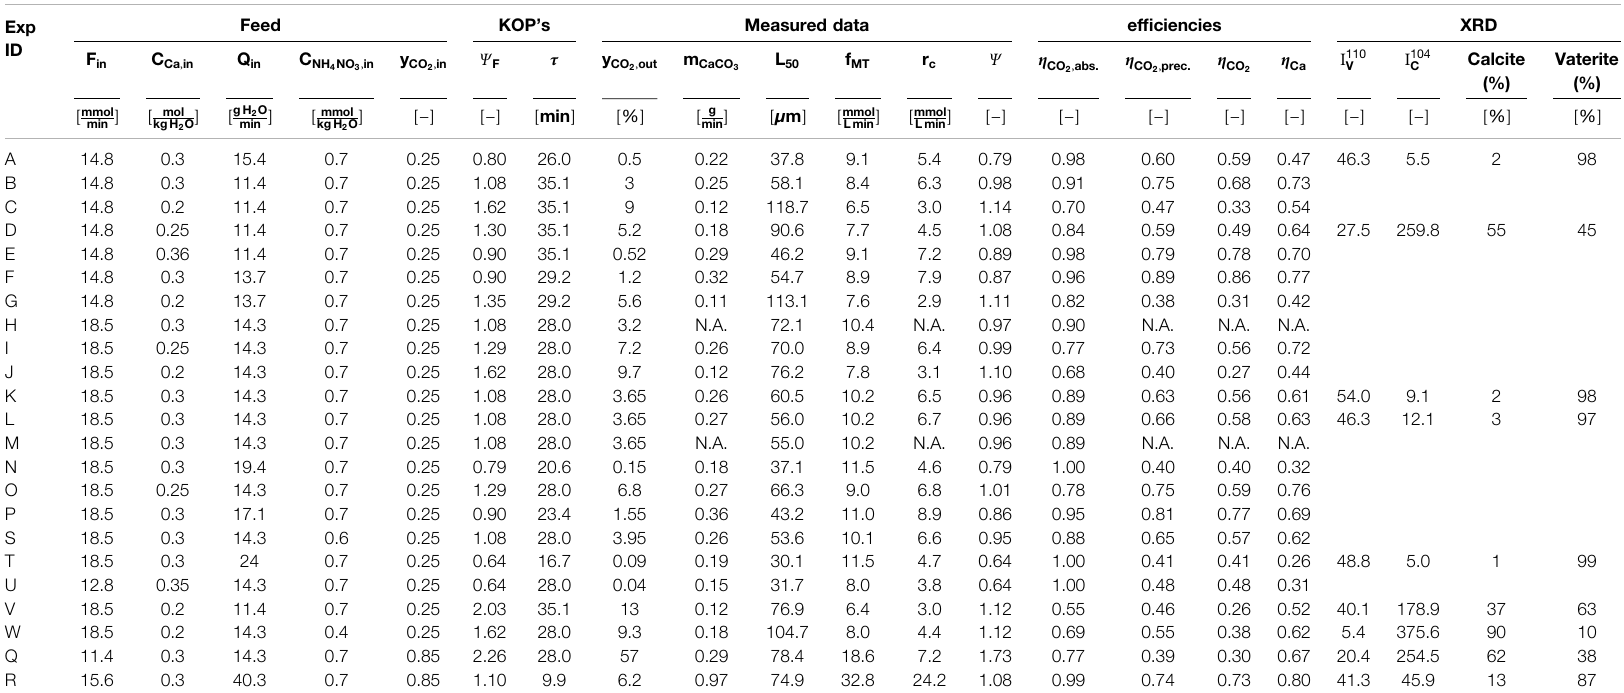
TABLE 1 | The feed conditions, KOP as well as the downstream data and the process ef fi ciencies are listed in the table below. All experiments listed were performed at 250 rpm, 25 ° C and a system pressure of 1.25 bars. Experiment m was conducted at a stirring rate of 350 rpm. Feed KOP ’ s Measured data ef fi ciencies